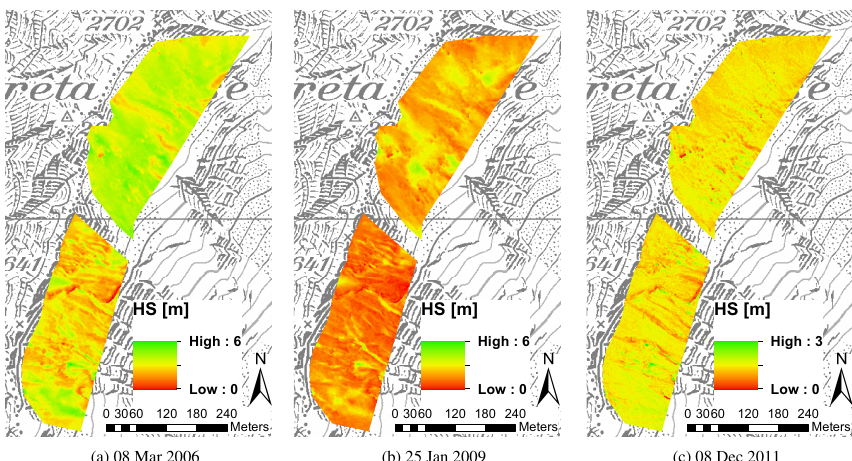
Fig. A8. Snow depth distributions in the basins CB1 and CB2. Pixmaps © 2013 swisstopo (5704 000 000). Fig. A8: Snow depth distributions in the basins CB1 and CB2. Pixmaps© 2013 swisstopo (5704 000 000).